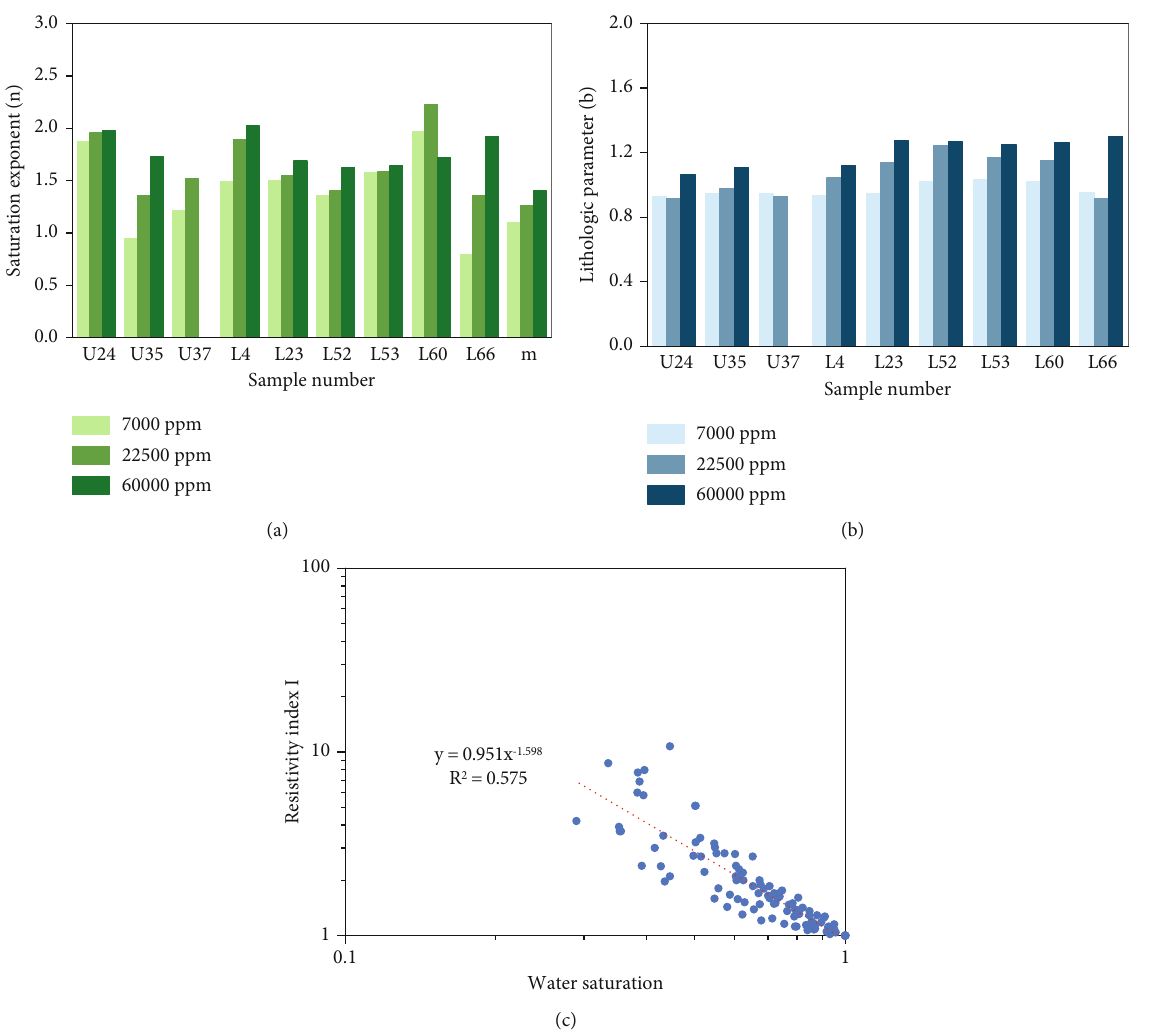
Figure 8: Comparative analysis results of b and n in LZ shale samples under di ff erent salinity. (a) Saturation exponent in every sample; (b) lithologic parameter b ; (c) saturation exponent obtained from all sample data under formation water of 22500